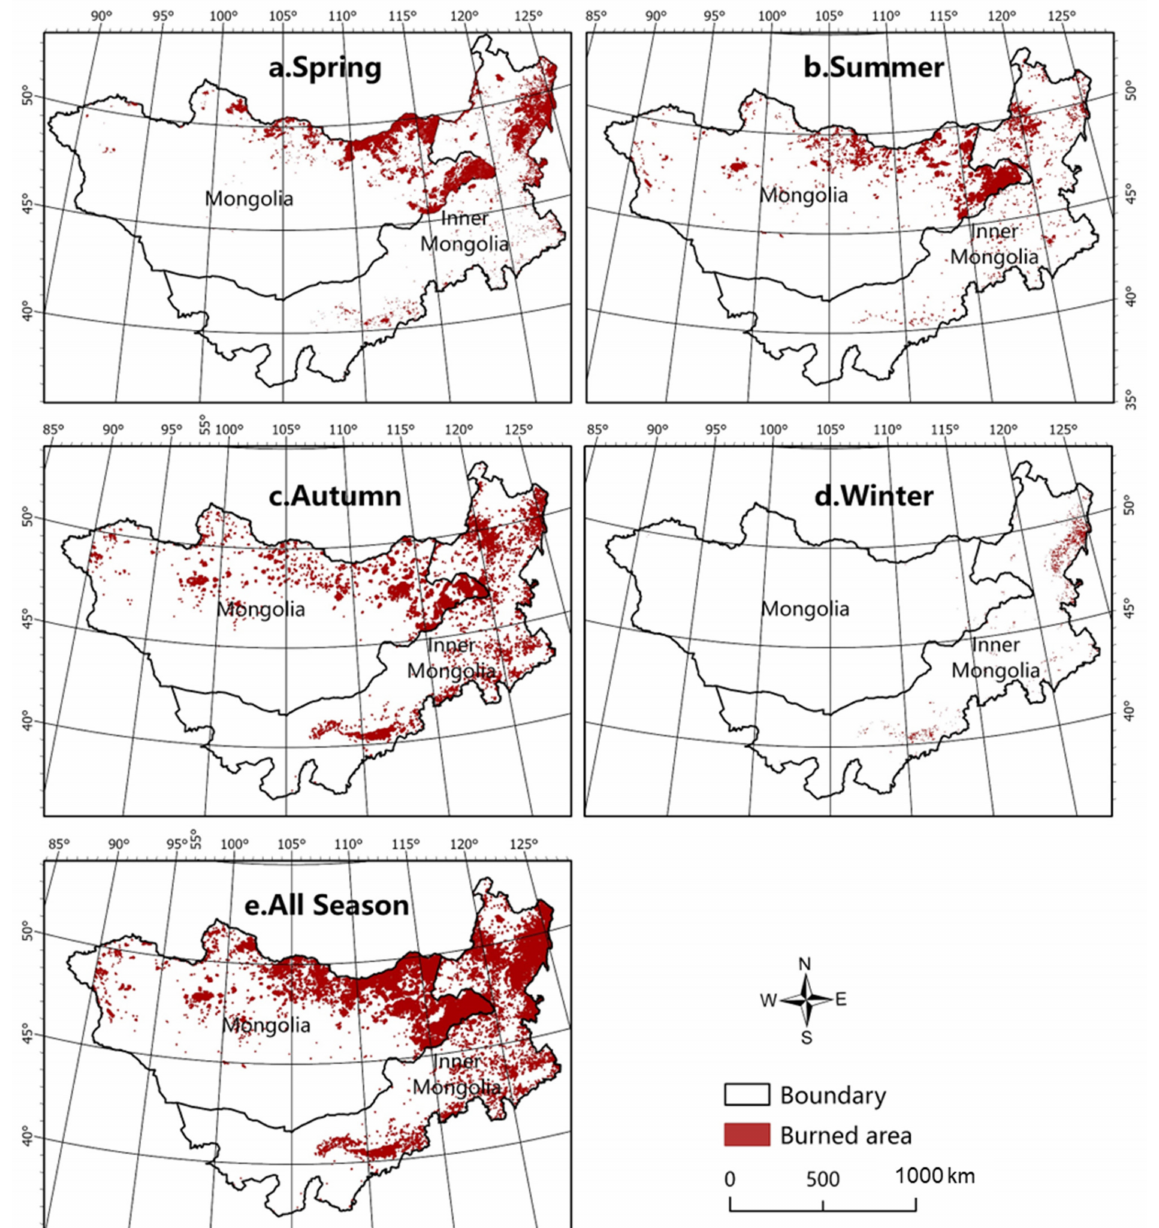
Figure 5. Burned area distribution map in the Mongolian Plateau from 2001 to 2021. Spring ( a ): 57% of the burned area occurred in spring; Summer ( b ): 22% of the burned area occurred in summer; Autumn ( c ): 20% of the burned area occurred in autumn; Winter ( d ): only 1% of the burned area occurred in winter. All-season ( e ): 77% of the total burned area of the whole period occurred in Mongolia and only 23% of burned area in Inner